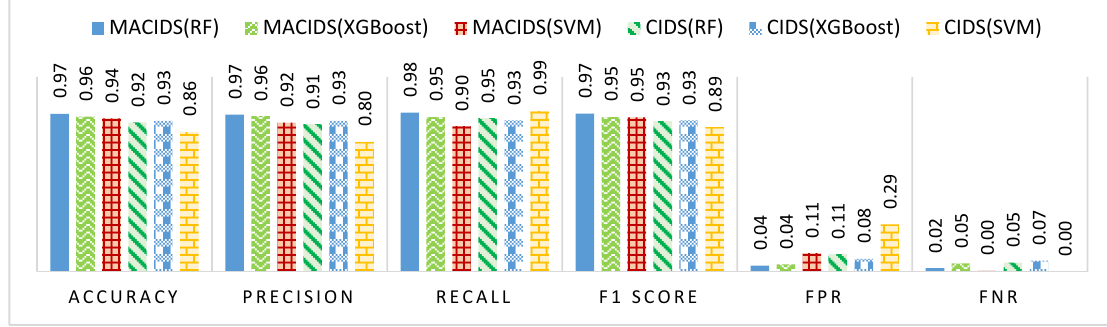
Figure 3. Comparisons of the detection performance. Table 4. Details of the detection performance.